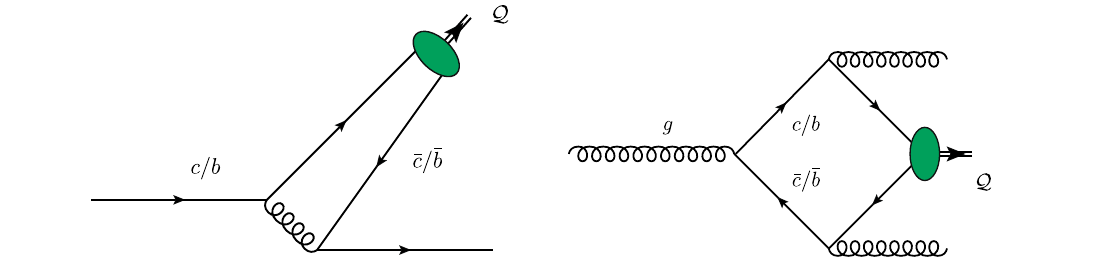
final state features no DGLAP evolution, logarithms are